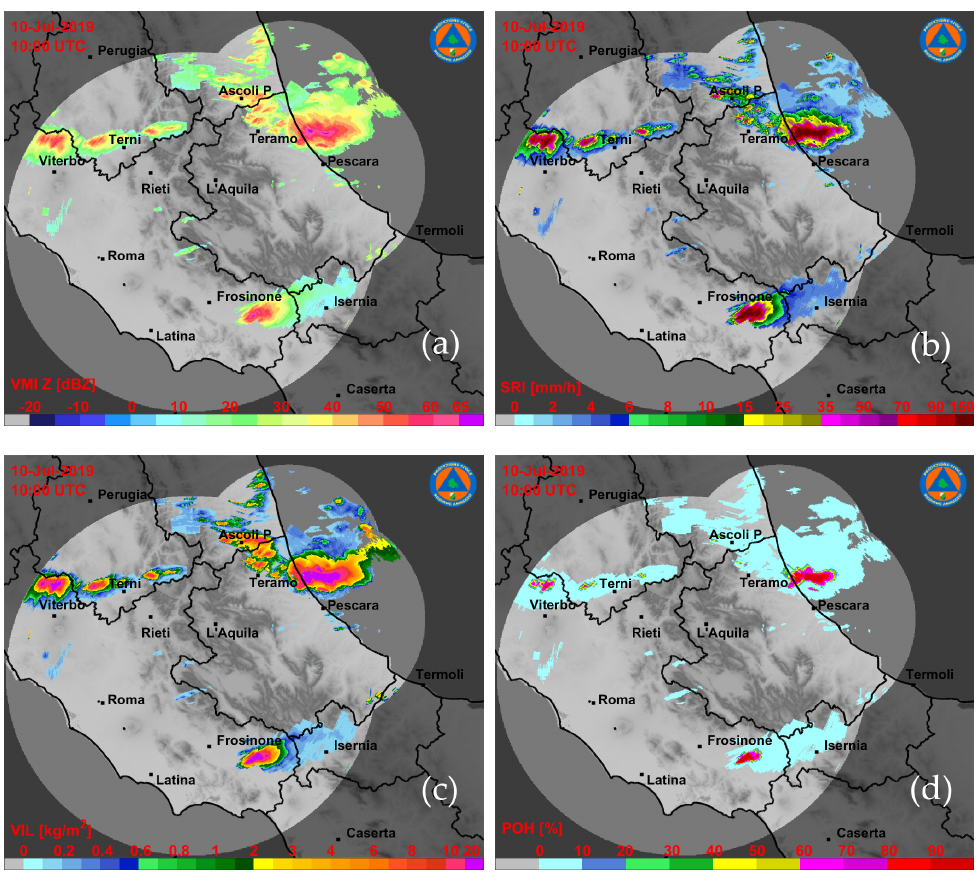
Figure 9. Composite radar products generated by CRAMS for the event occurring on 10 July,